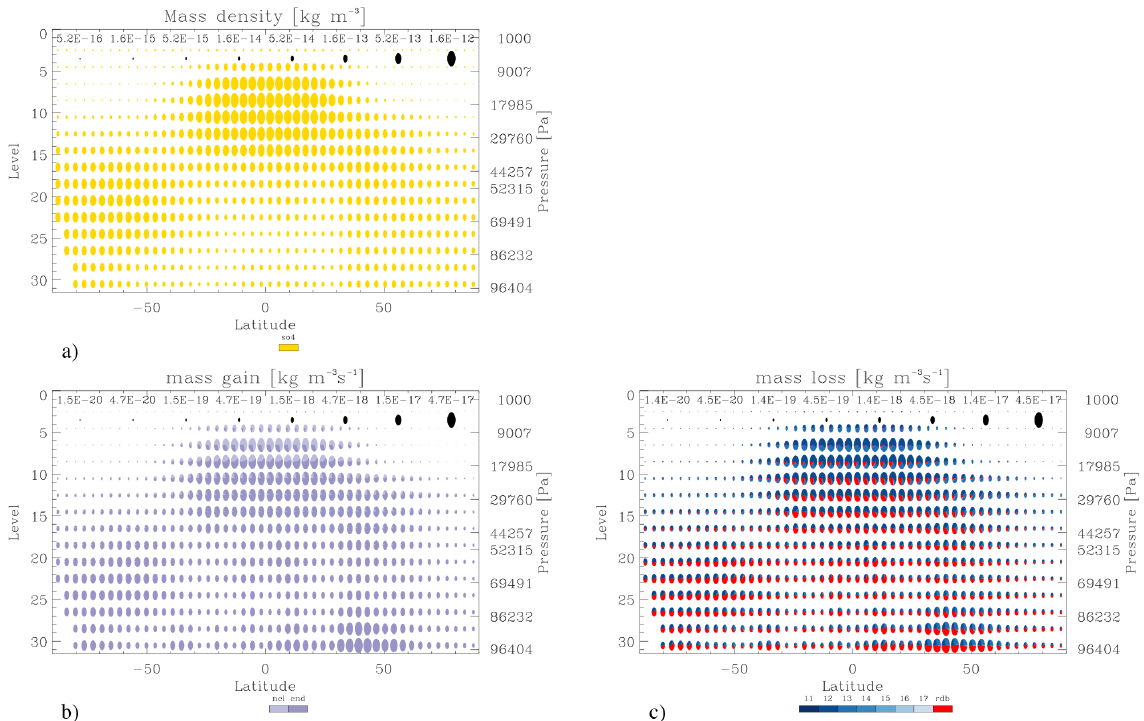
Figure 6. Zonal distribution of annual densities (a) and tendencies ( b and c ) of the nucleation mode. The colors indicate either species (defined in Table 3) or processes (defined in Table 2). The pie chart shows fractional contributions, while the radius of the pie indicates the zonally averaged density or tendency (logarithmic scale as shown in black at the top of the panels a, b and c ).